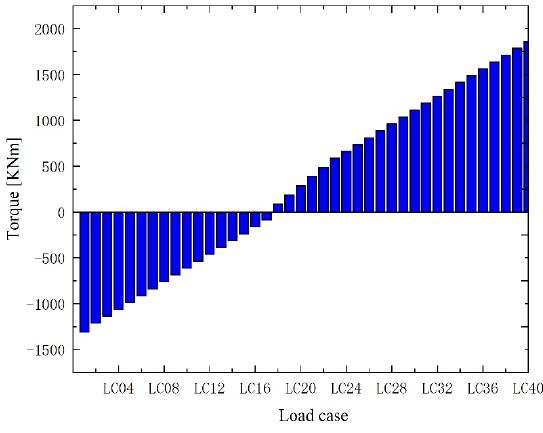
Figure 12. Load spectrum.